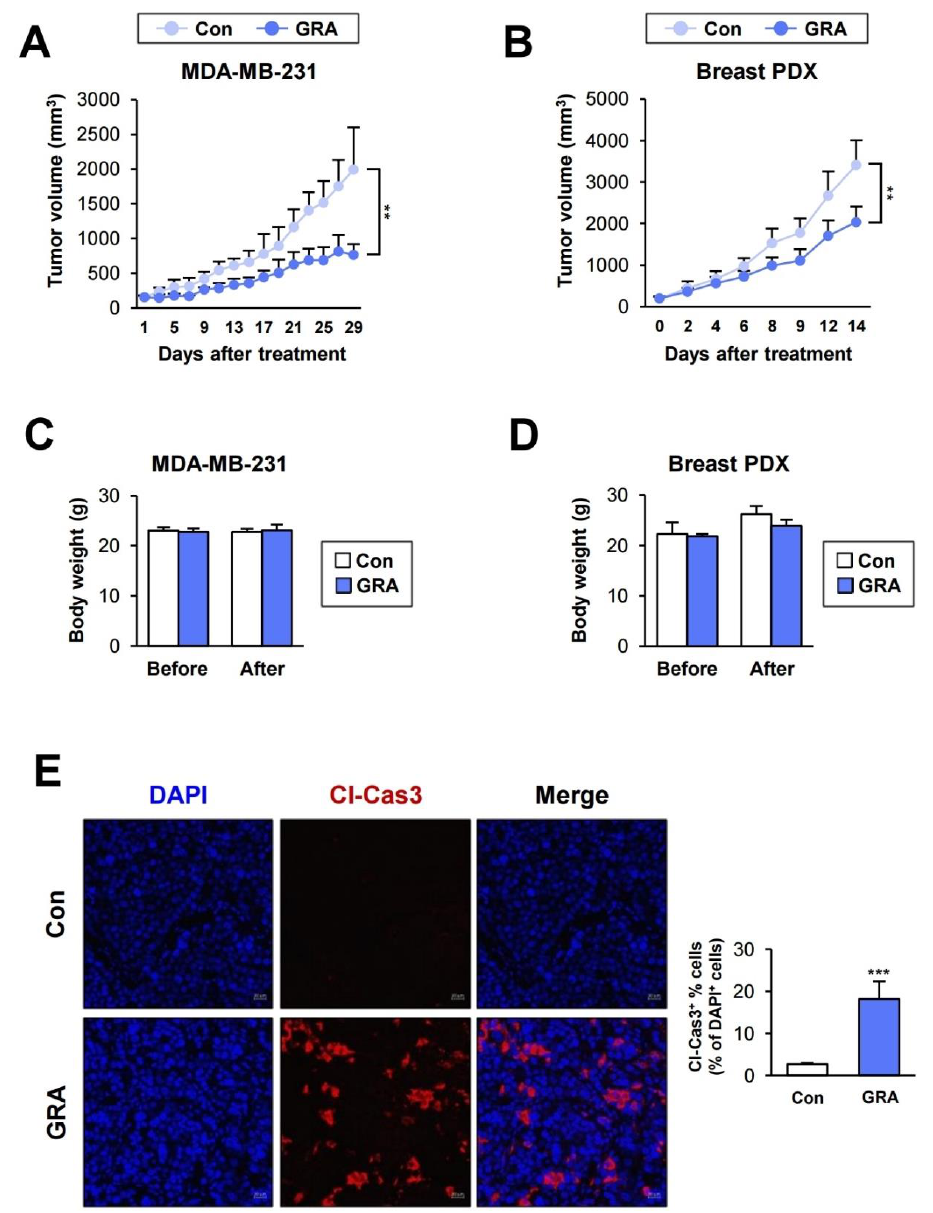
Figure 4. Antitumor effect of gracillin in vivo. ( A , B ) Antitumor effects of gracillin in tumor xenograft models established by inoculating MDA-MB-231 cells ( A ) and breast patient-derived tumor tissues ( B ) into mice. ( C , D ) Body weight changes in vehicle- or gracillin-treated mice. ( E ) Immunofluorescence analyses of cleaved caspase-3 (Cl-Cas3) expression in patient-derived xenograft (PDX) tumors from vehicle- and gracillin-treated mice. Scale bar: 20 μm. The bars represent the mean ± SD; ** p < 0.01 and *** p < 0.001, as determined by a two-tailed Student’s t -test by comparison with the vehicle-treated control group. Con: control; GRA: